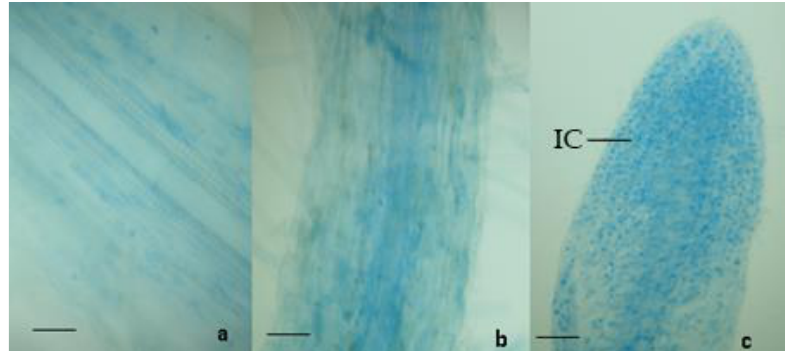
Figure 2. Light micrographs of zucchini roots stained with Tryptan blue and Pelikan blue dyes. ( a ) and ( b ): roots sections of control (not inoculated); ( c ): apex of primary root inoculated with T. harzianum T22, IC: intracellular structures; Bars = 100 μm.